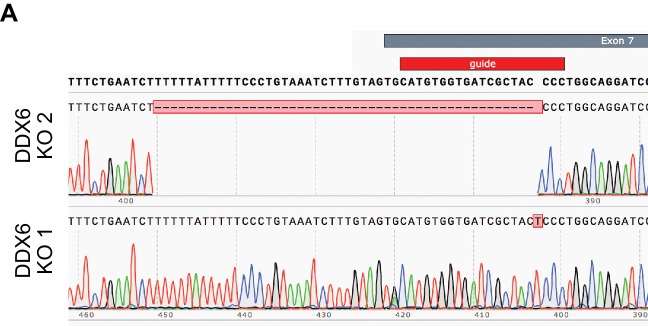
Characterization of Ddx6 KO ESCs.(A) Sanger sequencing showing deletion and insertion at the beginning of exon seven to generate two Ddx6 KO clones.